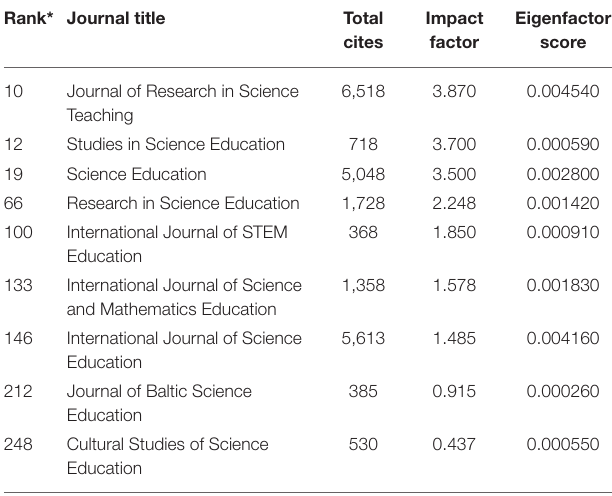
TABLE 1 | The selected science-education journal